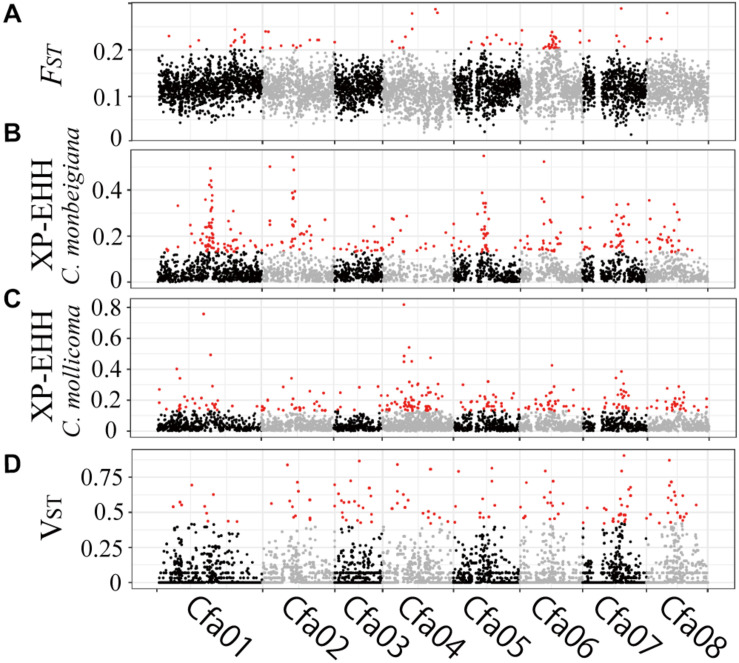
Genomic regions with high divergence or selected signals. (A) Pairwise genetic divergence of SNPs (FST) in 50-kb sliding windows across all chromosomes for all comparisons. Divergence outliers (P < 0.01) are shown in red. Selection of SNPs (XP-EHH) in 50-kb sliding windows across all chromosomes for C. monbeigiana
(B) and C. mollicoma
(C). Divergence outliers (P < 0.01) are shown in red. (D) Pairwise genetic divergence of CNVs (VST) in 10-kb sliding windows across all chromosomes for all comparisons. Divergence outliers (P < 0.05) are shown in red.